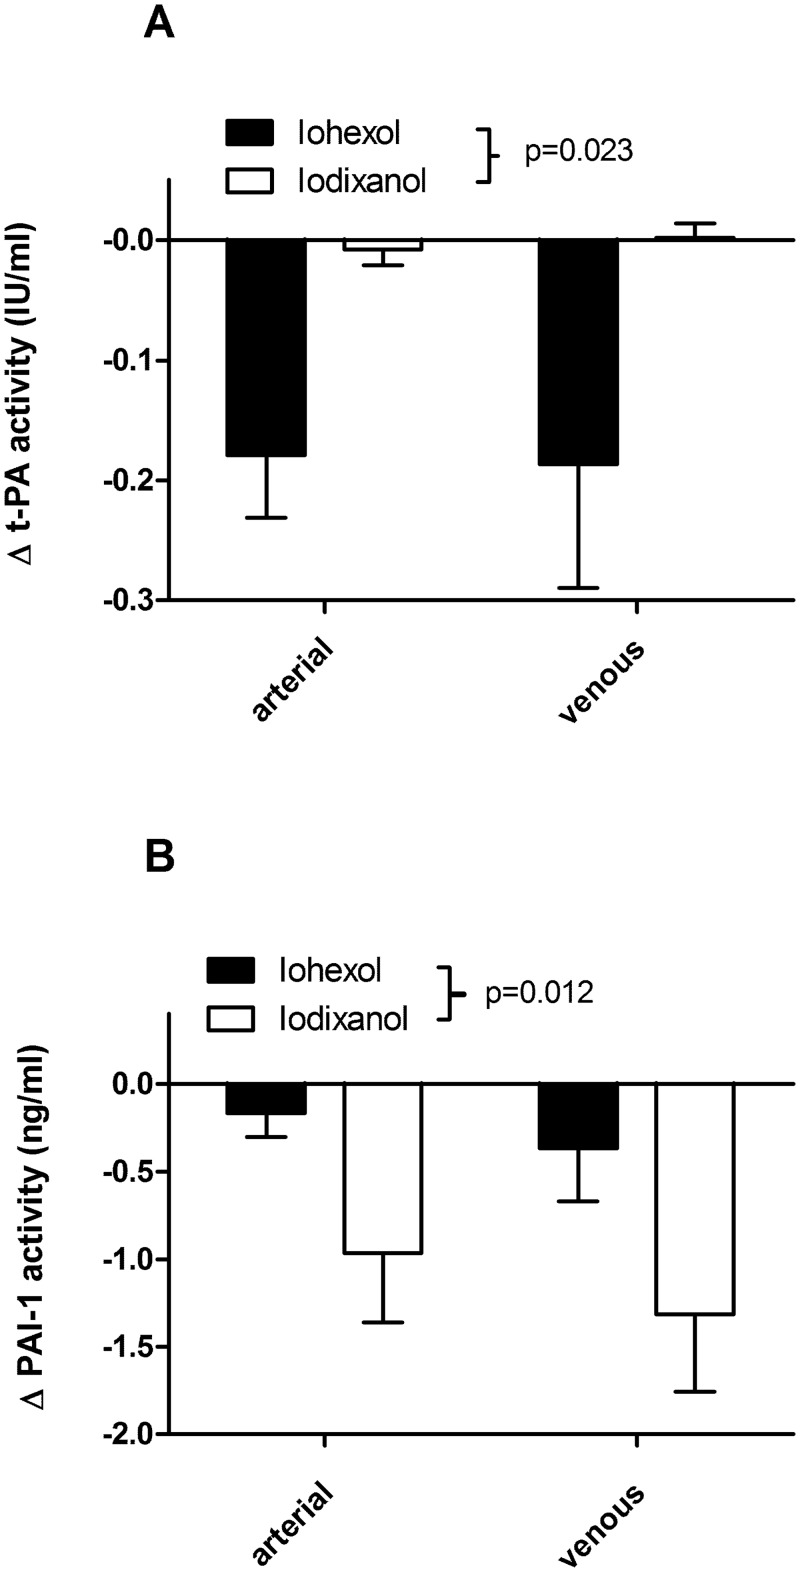
Change in (A) t-PA and (B) PAI-1 activity in arterial and venous blood samples post angiography compared to baseline in patients receiving iohexol and iodixanol.t-PA activity was significantly reduced in the iohexol group; PAI-1 activity was significantly reduced in the iodixanol group (2-way repeated measures ANOVA, P value shown is between treatment groups; n = 6 in each group). There was no interaction between treatment groups and arterial/venous plasma.